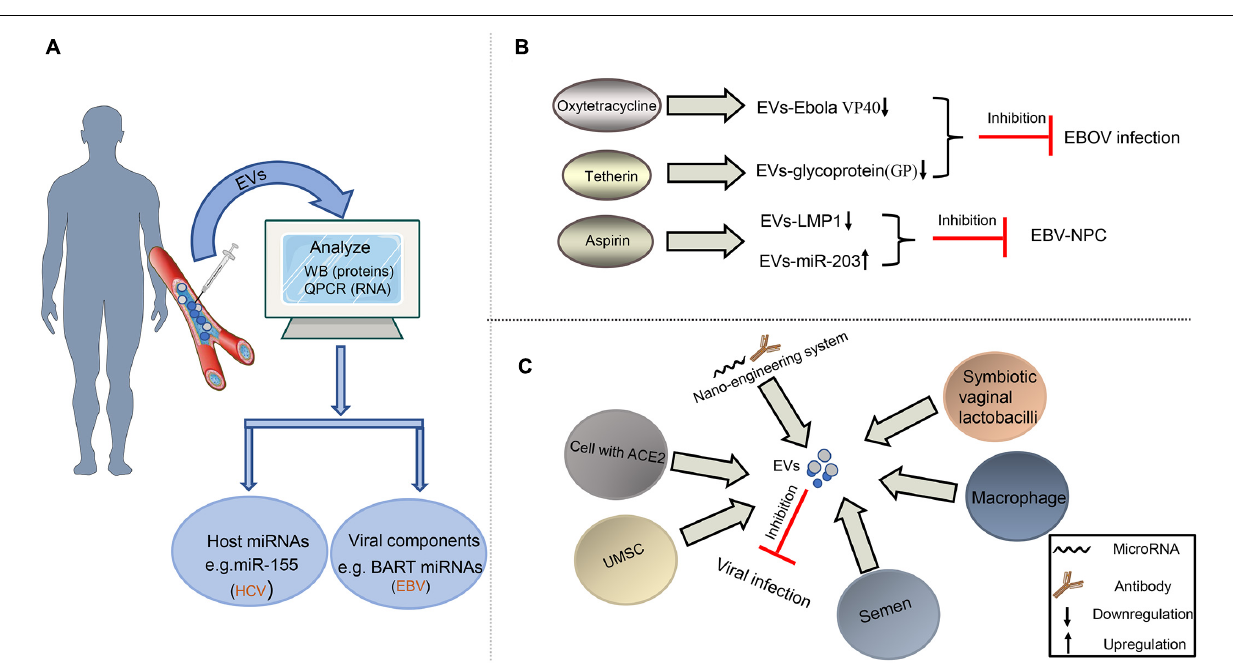
Frontiers in Cell and Developmental Biology |